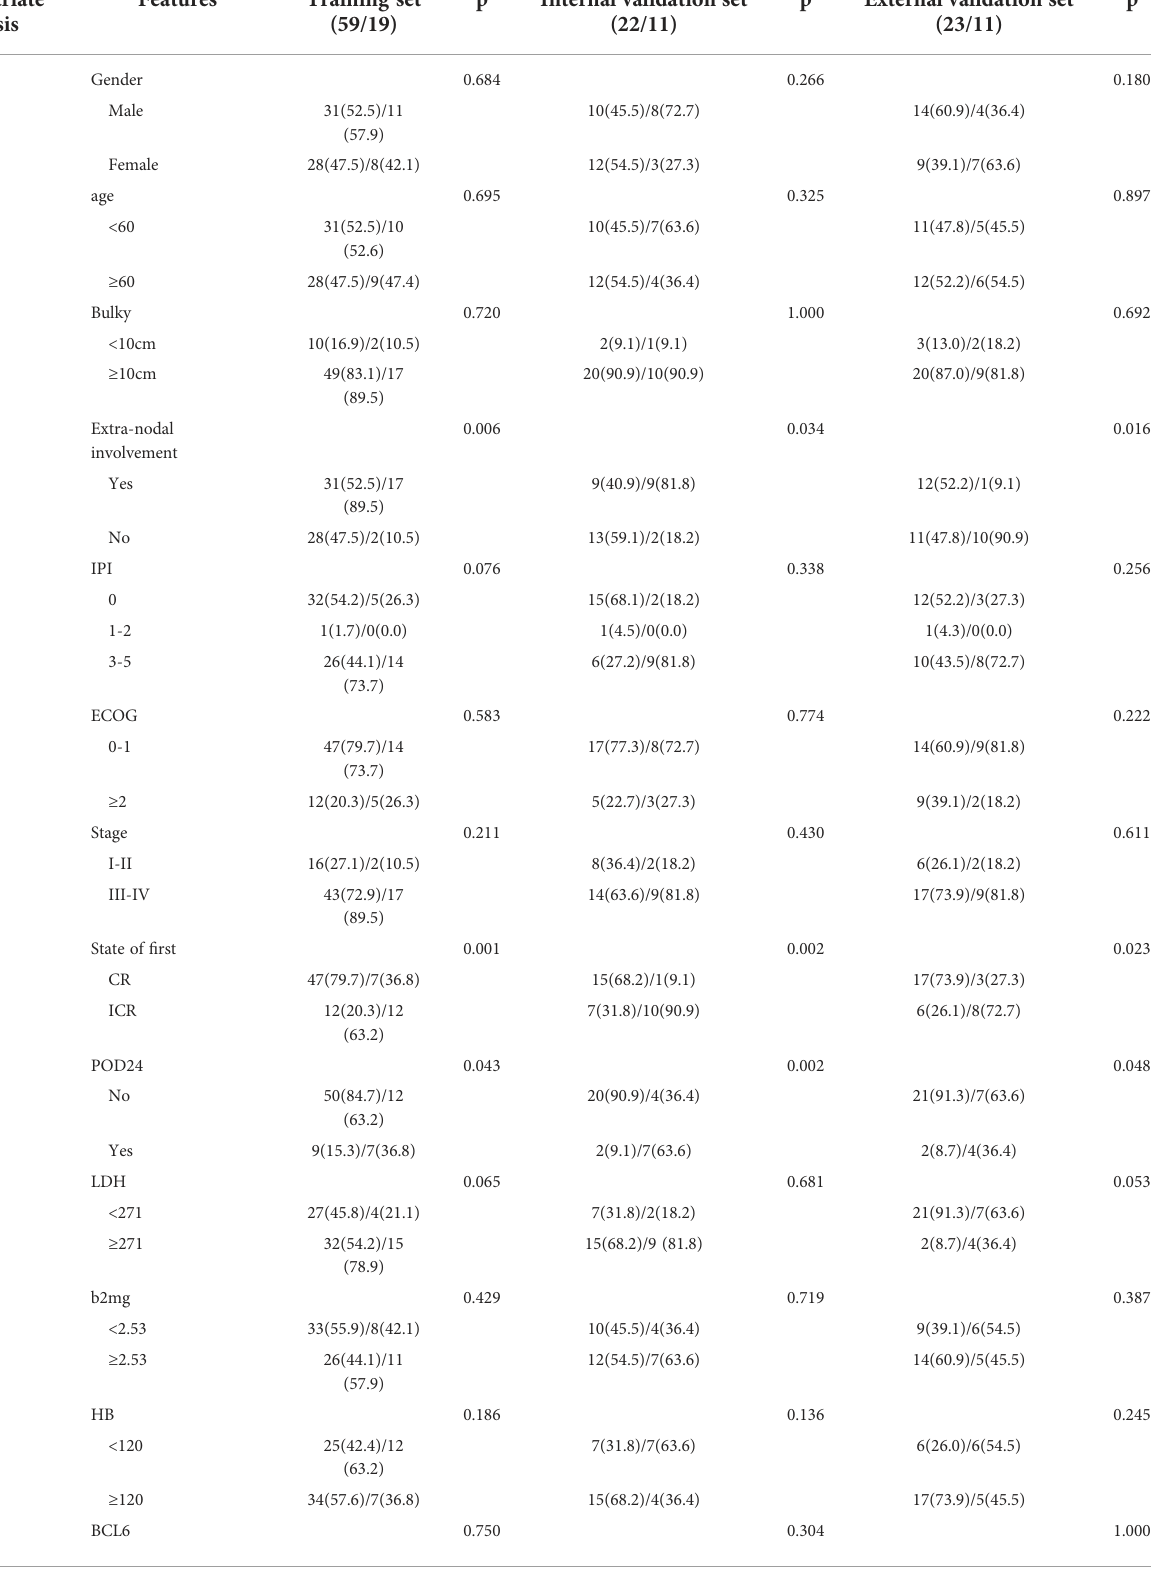
TABLE 2 Clinic and ultrasound features between survival group and death